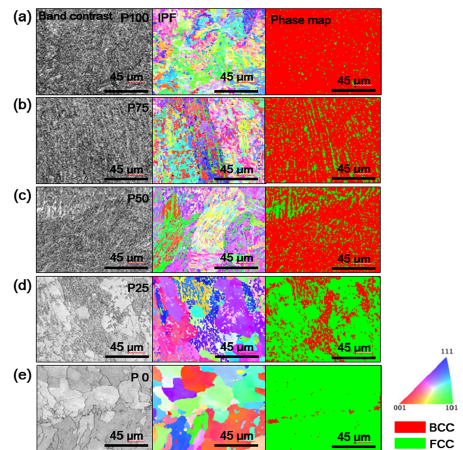
Figure 10. EPMA band contrast, IPF and phase map analysis by location and mixing ratio in FGM samples: ( a ) P21 100–STS316L 0%; ( b ) P21 75–STS316L 25%; ( c ) P21 50–STS316L 50%; ( d ) P21 25– STS316L 75%; ( e ) P21 0–STS316L 100%.